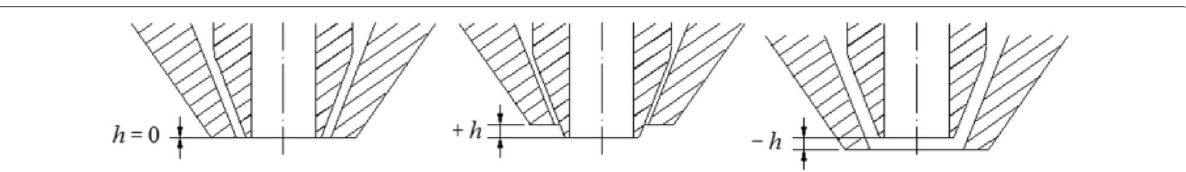
Figure 4 Relative position between the outer and inner nozzles